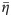
Induced recommendation graphs and sample visualizations.(a) Induced recommendation graphs plotted according to number of nodes in the graph (N) and mean random walk entropy (η¯). Points are colored according to number of views, on a log scale presented on the right. Solid green lines indicate medians, red dashed line is a linear regression of the distribution. Three points are marked in this latter line: one at each extremity and one in its middle. The three sample graphs (b), (c) and (d) are the closest ones to the three points indicated in the regression line of plot (a). Nodes (and adjacent edges) are colored according to the category of the video they correspond to.